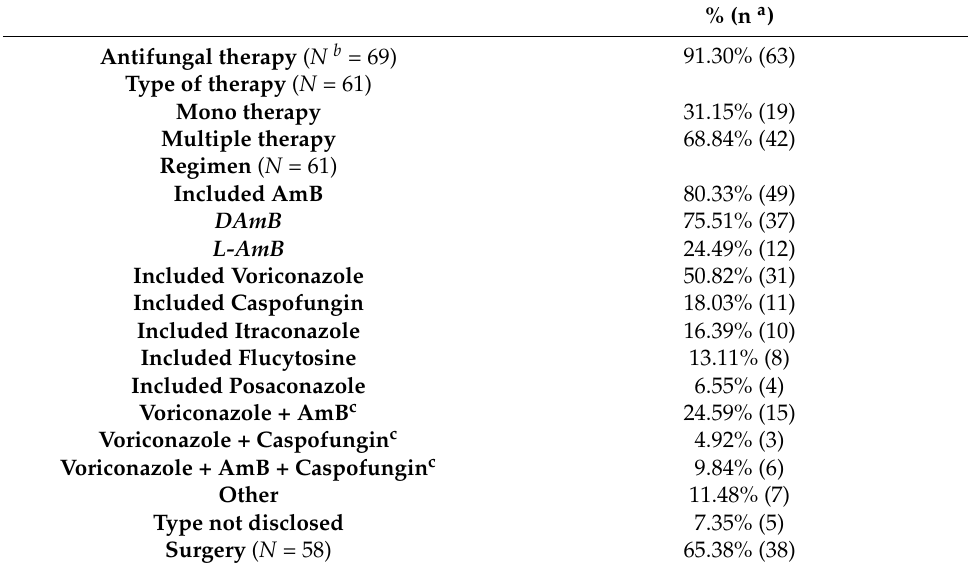
Table 7. Antifungal